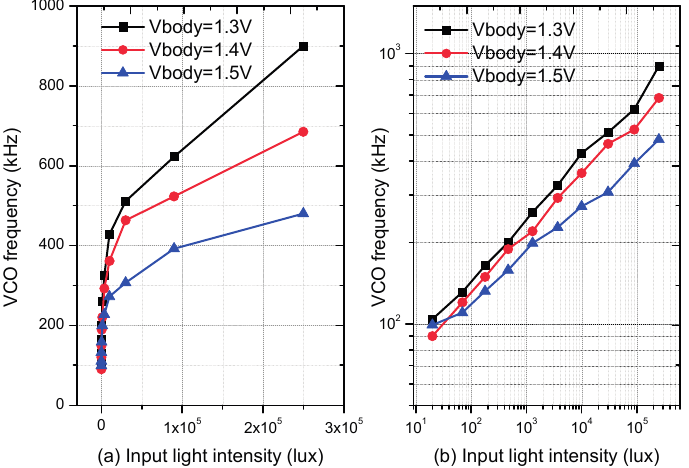
Figure 8. The measured VCO frequency from the test pixel structure with input light intensity ranging from 0 to 250 klux: ( a ) linear space; ( b ) logarithmic